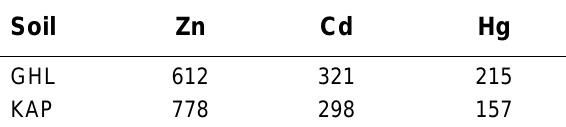
Total Amount of Zn, Cd, and Hg (mg/kg) Present in Contaminant-Spiked